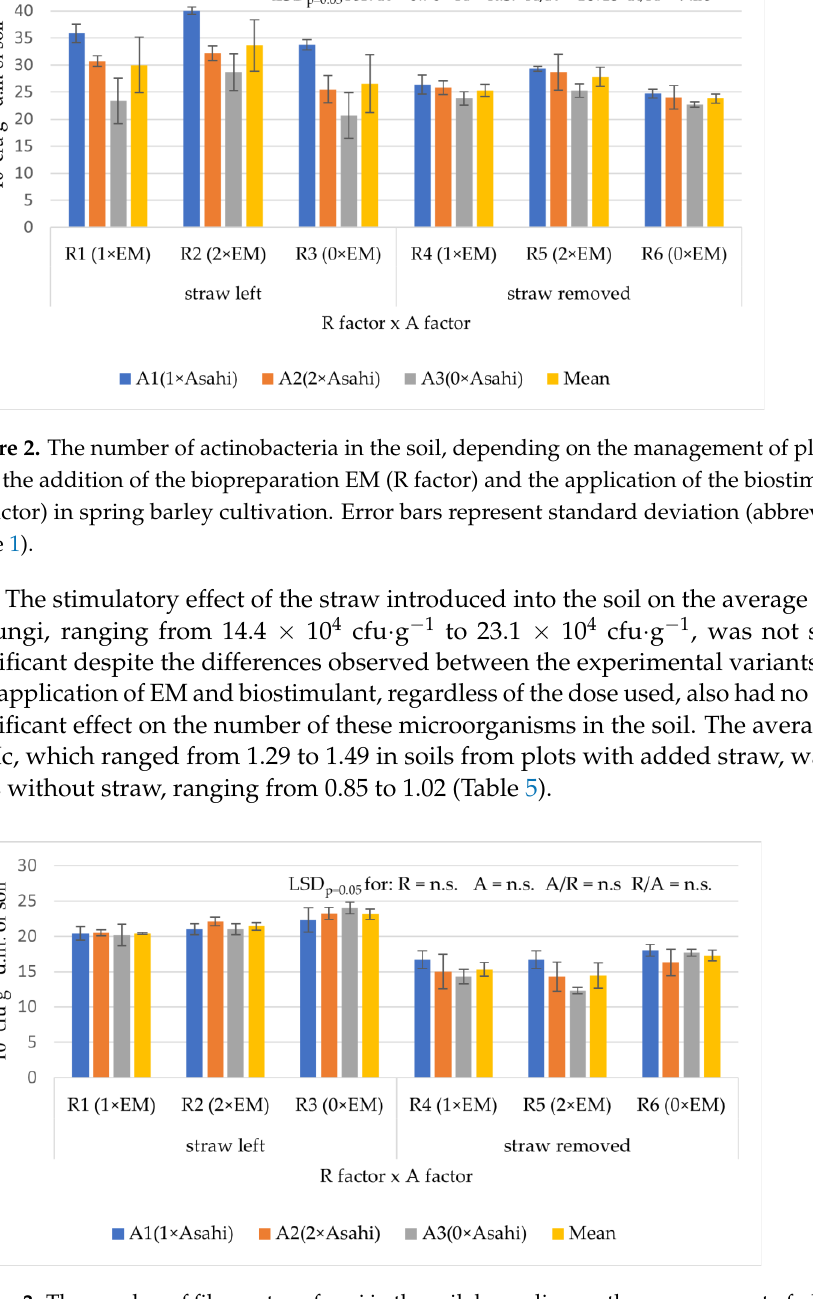
Figure 1. The number of bacteria in the soil, depending on the management of plant residues with the addition of the biopreparation EM (R factor) and the application of the biostimulant Asahi (A factor) in spring barley cultivation. Error bars represent standard deviation (abbreviations: see Table 1).